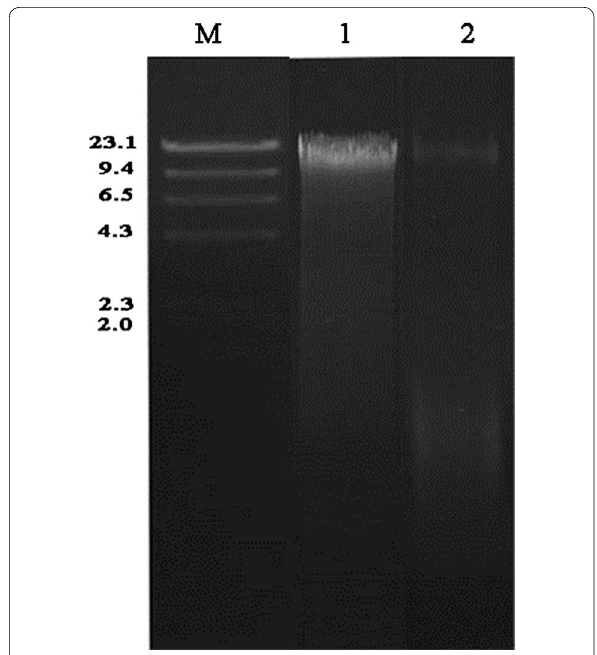
Fig. 3 Agarose gel electrophoresis of the genomic DNA extracted from the intestinal microflora of Cynoglossus semilaevis and Cyprinus carpio var . Jian using the CLU method. Lanes: M molecular marker. 1, Cynoglossus semilaevis ; and 2, Cyprinus carpio var . Jian